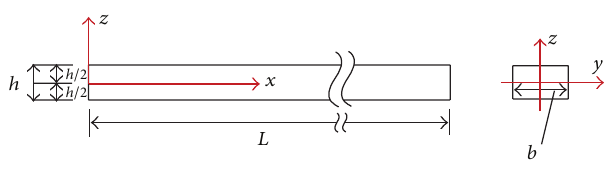
Figure 1: A schematic view of FG